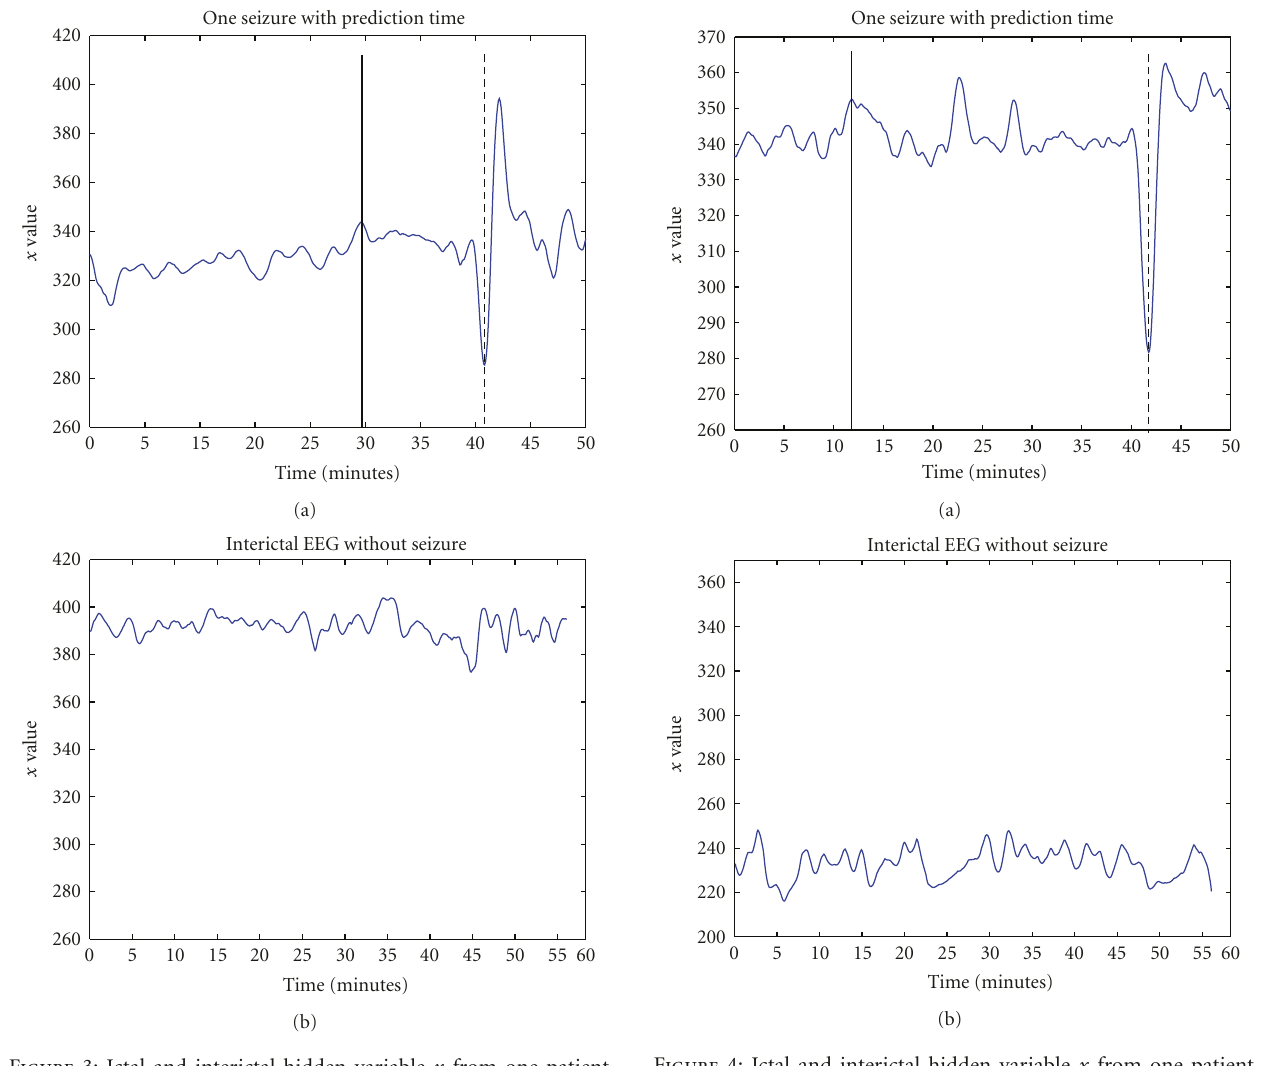
Figure 3: Ictal and interictal hidden variable x from one patient with epilepsy. The vertical solid line marks prediction time point and the vertical dashed line indicates seizure occurrence.